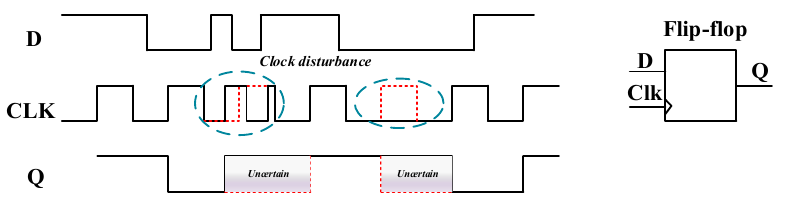
Figure 3. Clock disturbance of D flip ‐ flop.